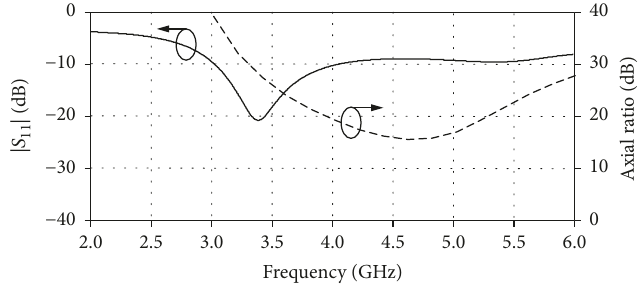
Figure 2: Simulated results of the truncated square patch